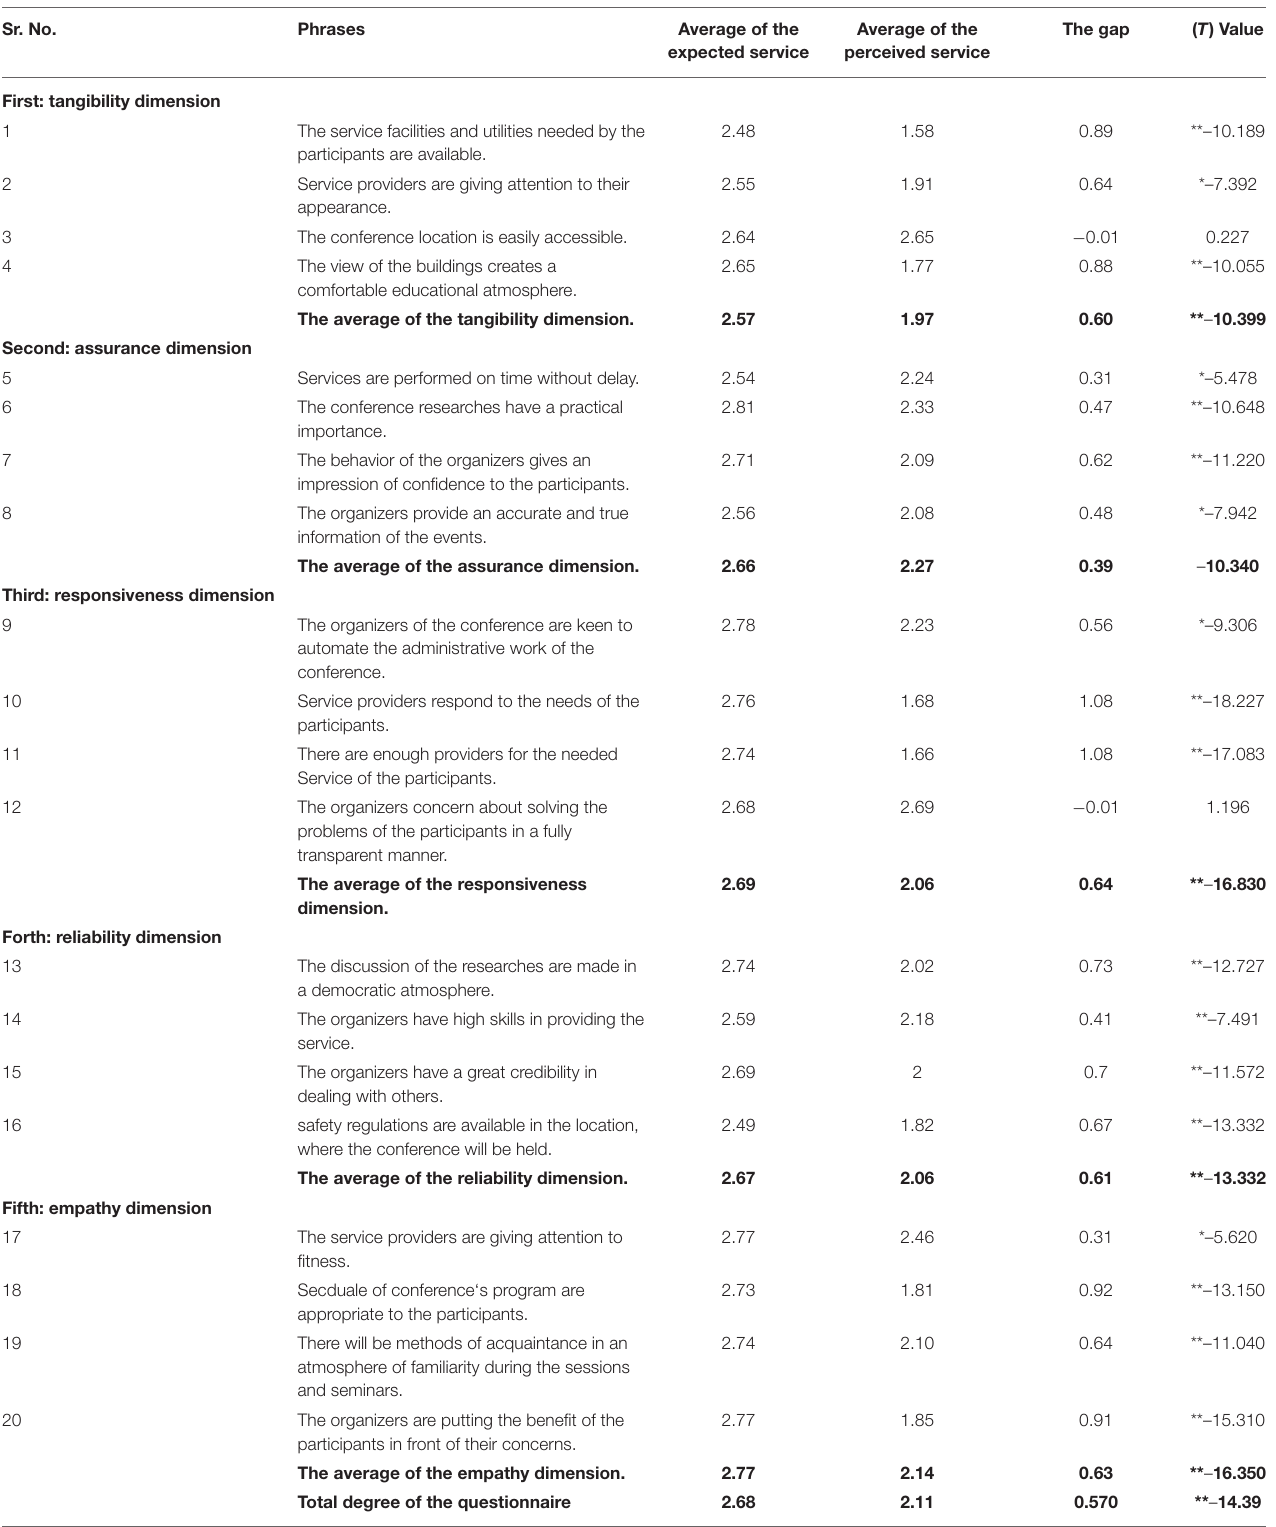
TABLE 4 | Participants’ perceptions and expectations for each of the dimensions of the provided service, the gap between them, and the calculated t -value. Sr.